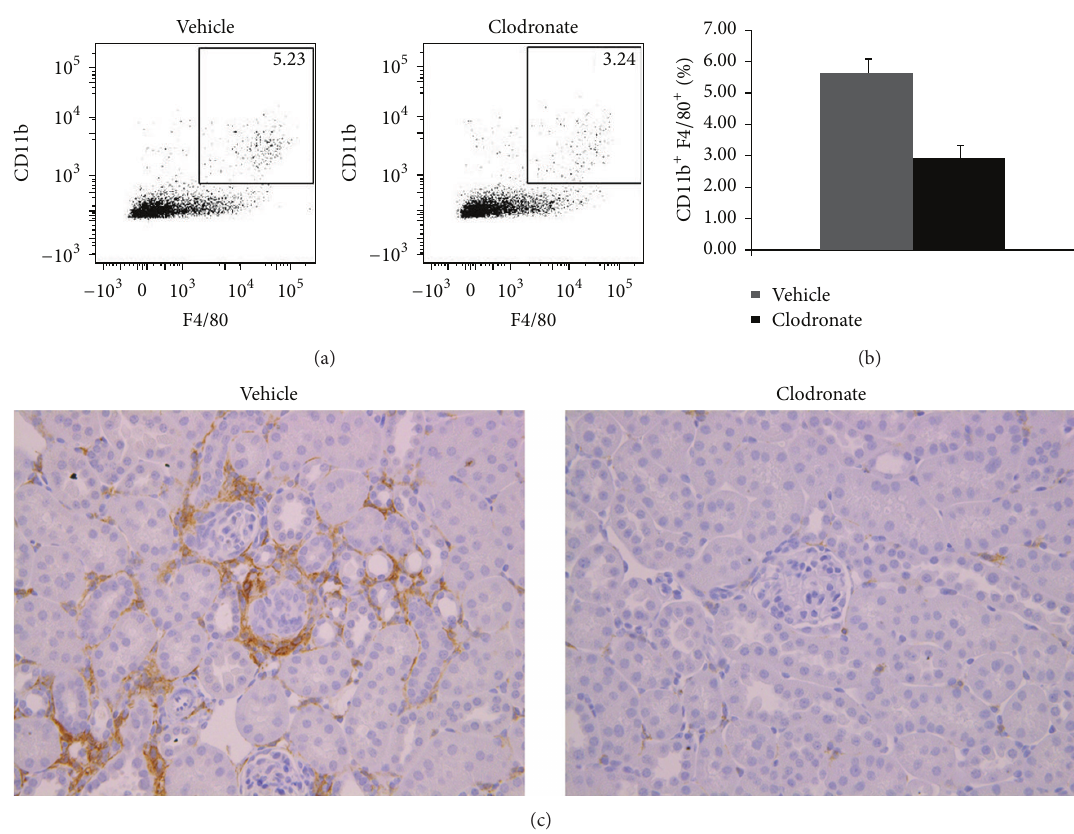
Figure 4: CD11b + and F4/80 + cells in kidneys of clodronate-treated or vehicle-treated (control) mice 7 days after release of a 6 day UUO. Representative flow cytometry is shown for CD11b + and F4/80 + (a) with data from all kidneys shown graphically (b). Representative immunohistochemical staining for F4/80 is also shown (c). 𝑁 = 5 per